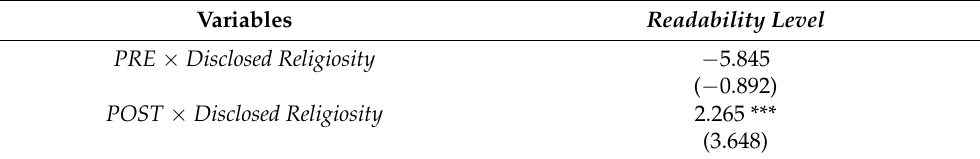
Table 9. Impact of CEO Religiosity on Annual Report Readability–Non-Religious to Religious CEO Turnover